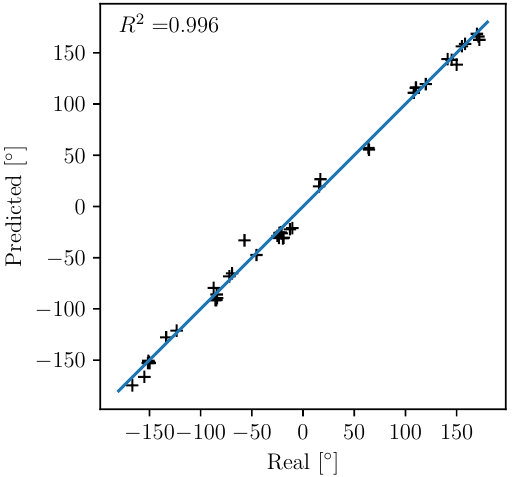
Figure 6. Predicted azimuth of the Sun versus real azimuth of reference in degrees based on the test set done in October 2020 and the optimized neural network. The continuous blue curve represents the ideal case when the observed values perfectly fit the predicted